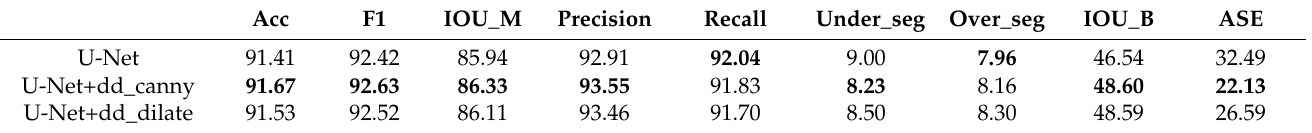
Figure 10. Mask label and two different boundary labels: ( a ) the mask label; ( b ) the canny boundary label; and ( c ) the dilated boundary label. Table 6. Comparison among different boundary labels. The bold number means the best result.